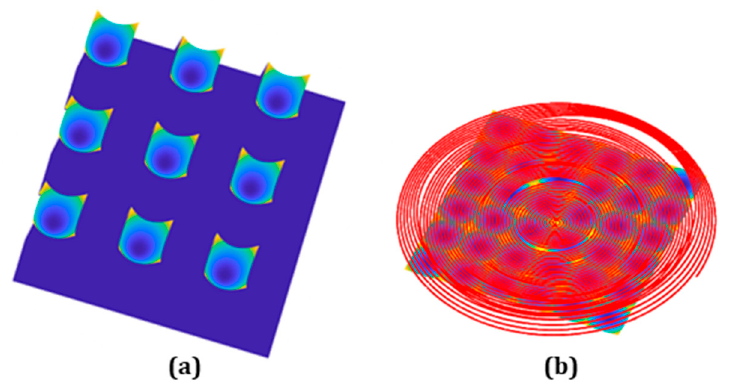
Figure 12. Tool path for fabricating lenslet array with concave lenslet. ( a ) One of the four lenslets is selected to fit the NURBS for the tool path in ( b ).